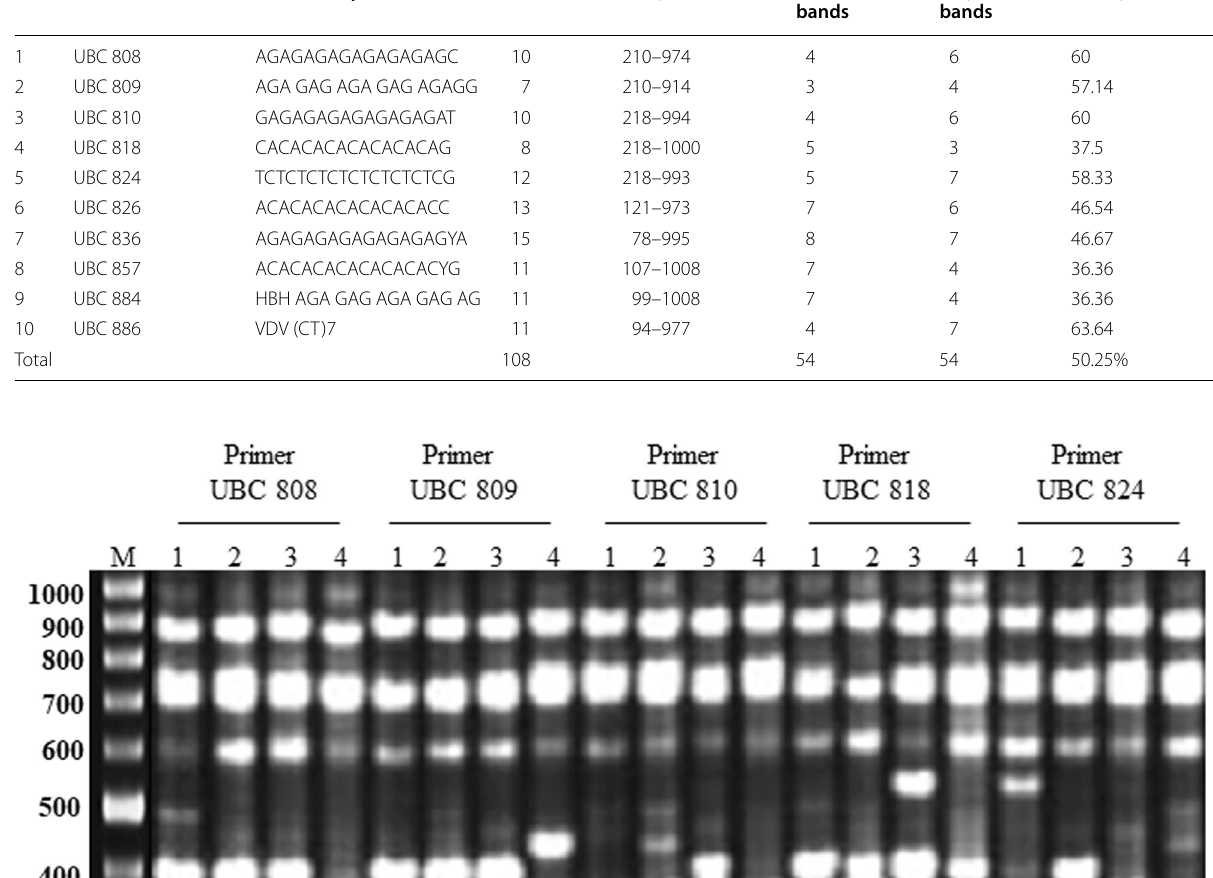
Table 5 ISSR profile analysis using 10 primers in Allium cepa treated with tap water as control, 25%, 50% and 100% of mixed wastewater at 12th day after germination No.